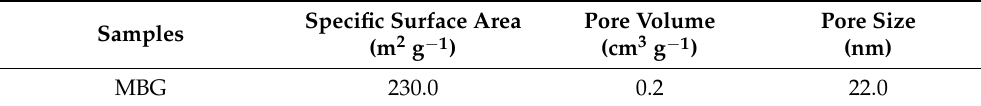
Figure 4. ( a ) N 2 adsorption-desorption isotherms and ( b ) pore size distribution curves of MBG nanofiber scaffold. Table 1. Specific surface area, pore volume, and nanopore size of MBG